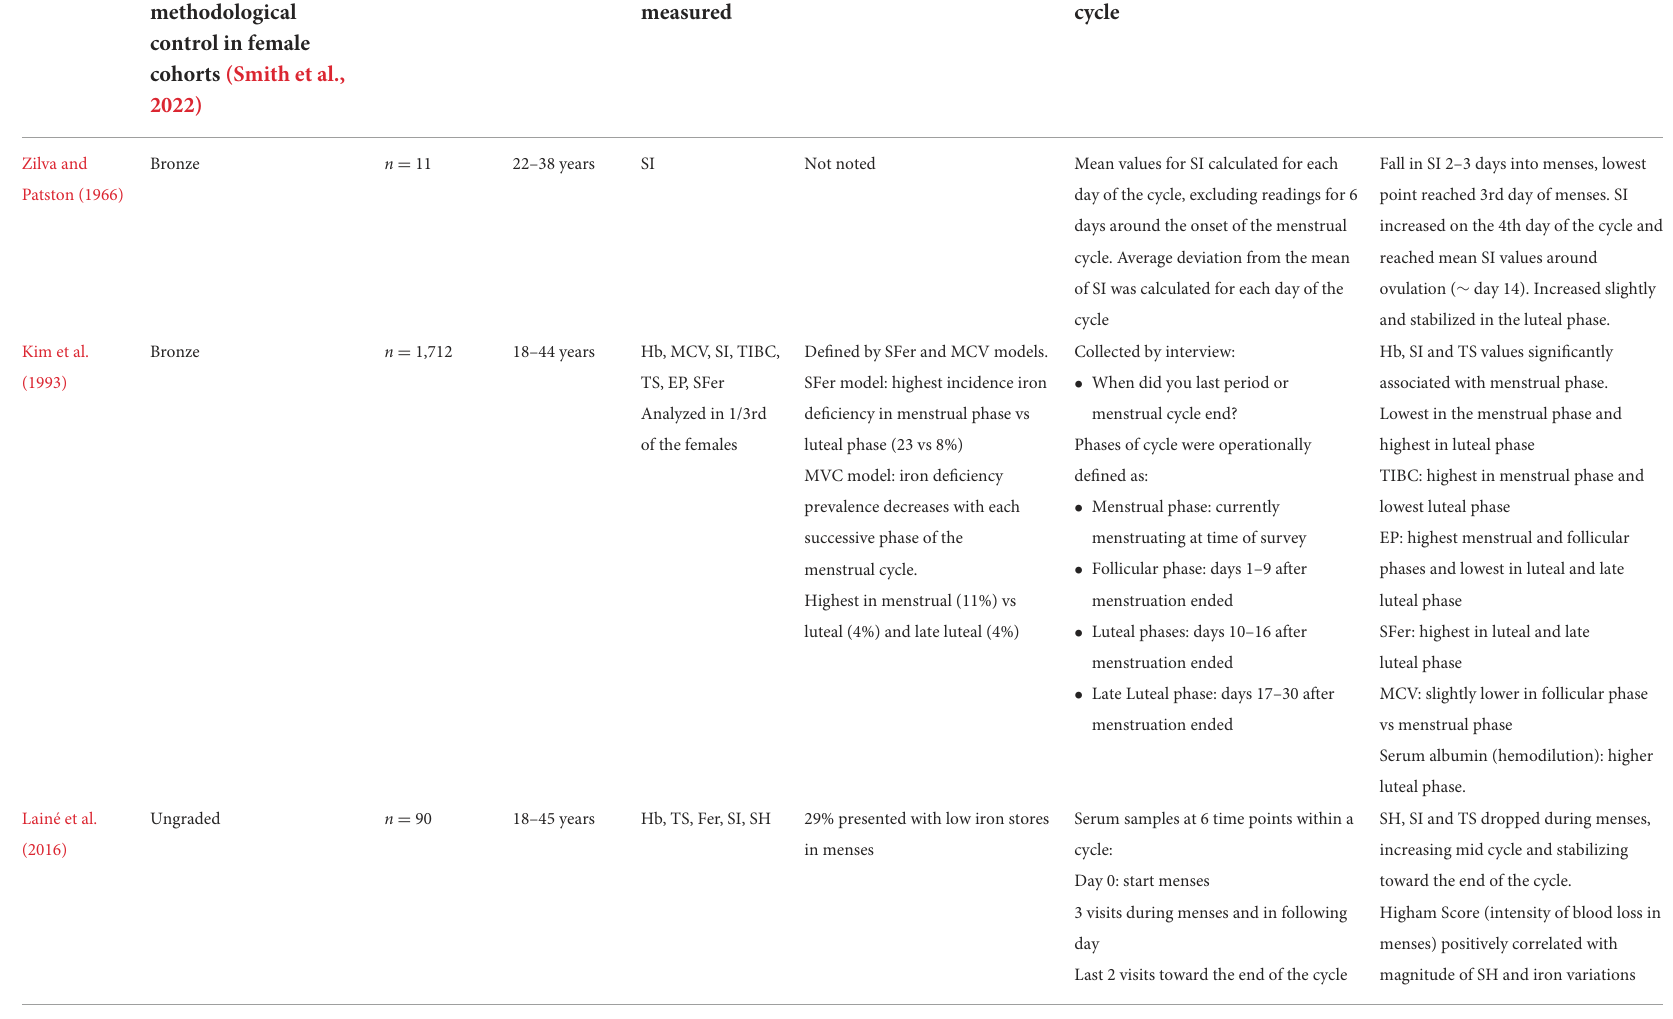
TABLE 1 Studies that have investigated iron status and hepcidin at different phases of the menstrual cycle in premenstrual